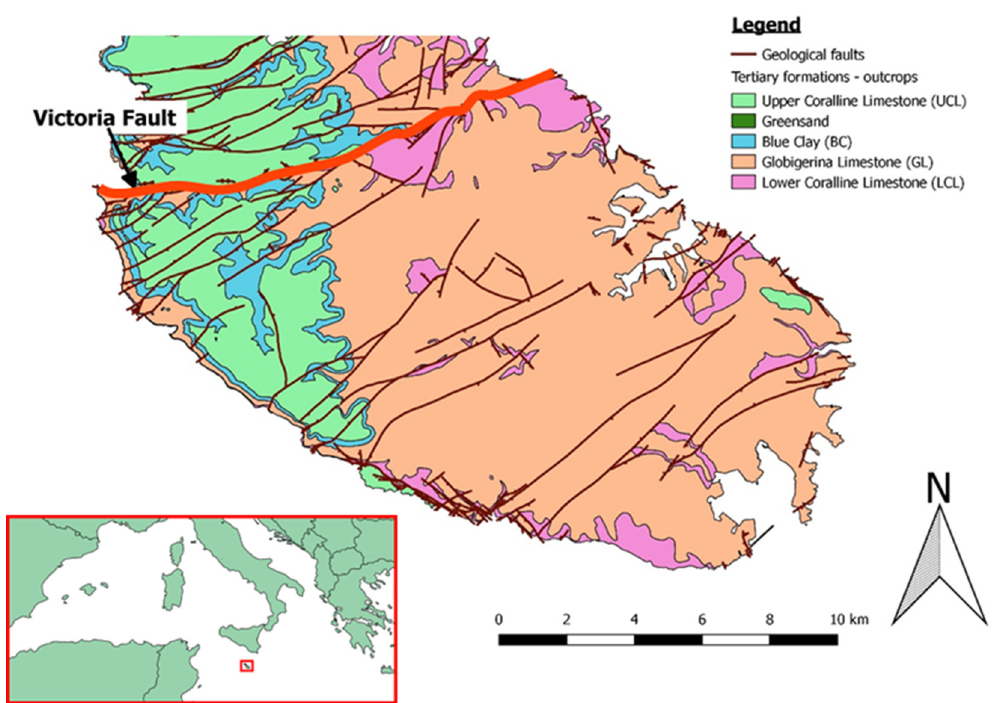
Figure 2. Simplified lithology and geological fault systems of the Maltese Island (modified after [35]).